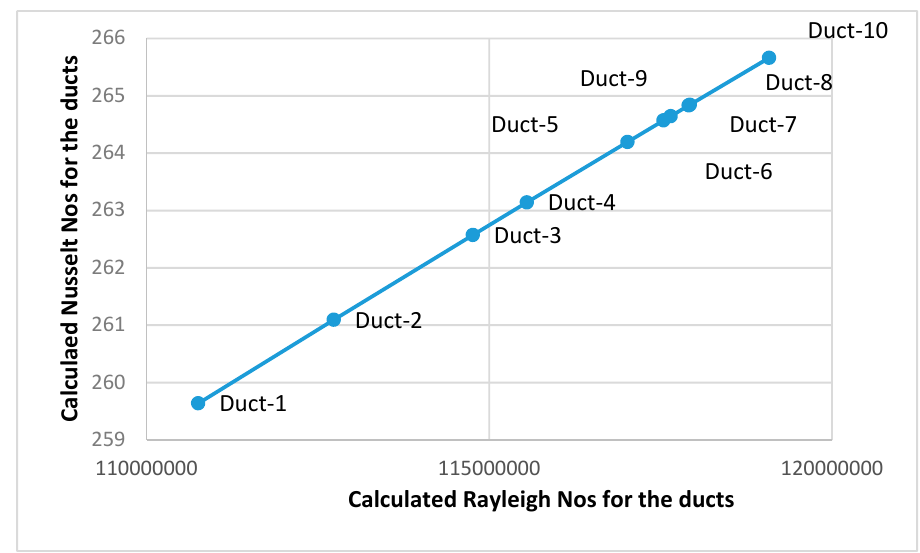
Figure 4. Nusselt and Rayleigh numbers plots for the studied duct width thermal flow.